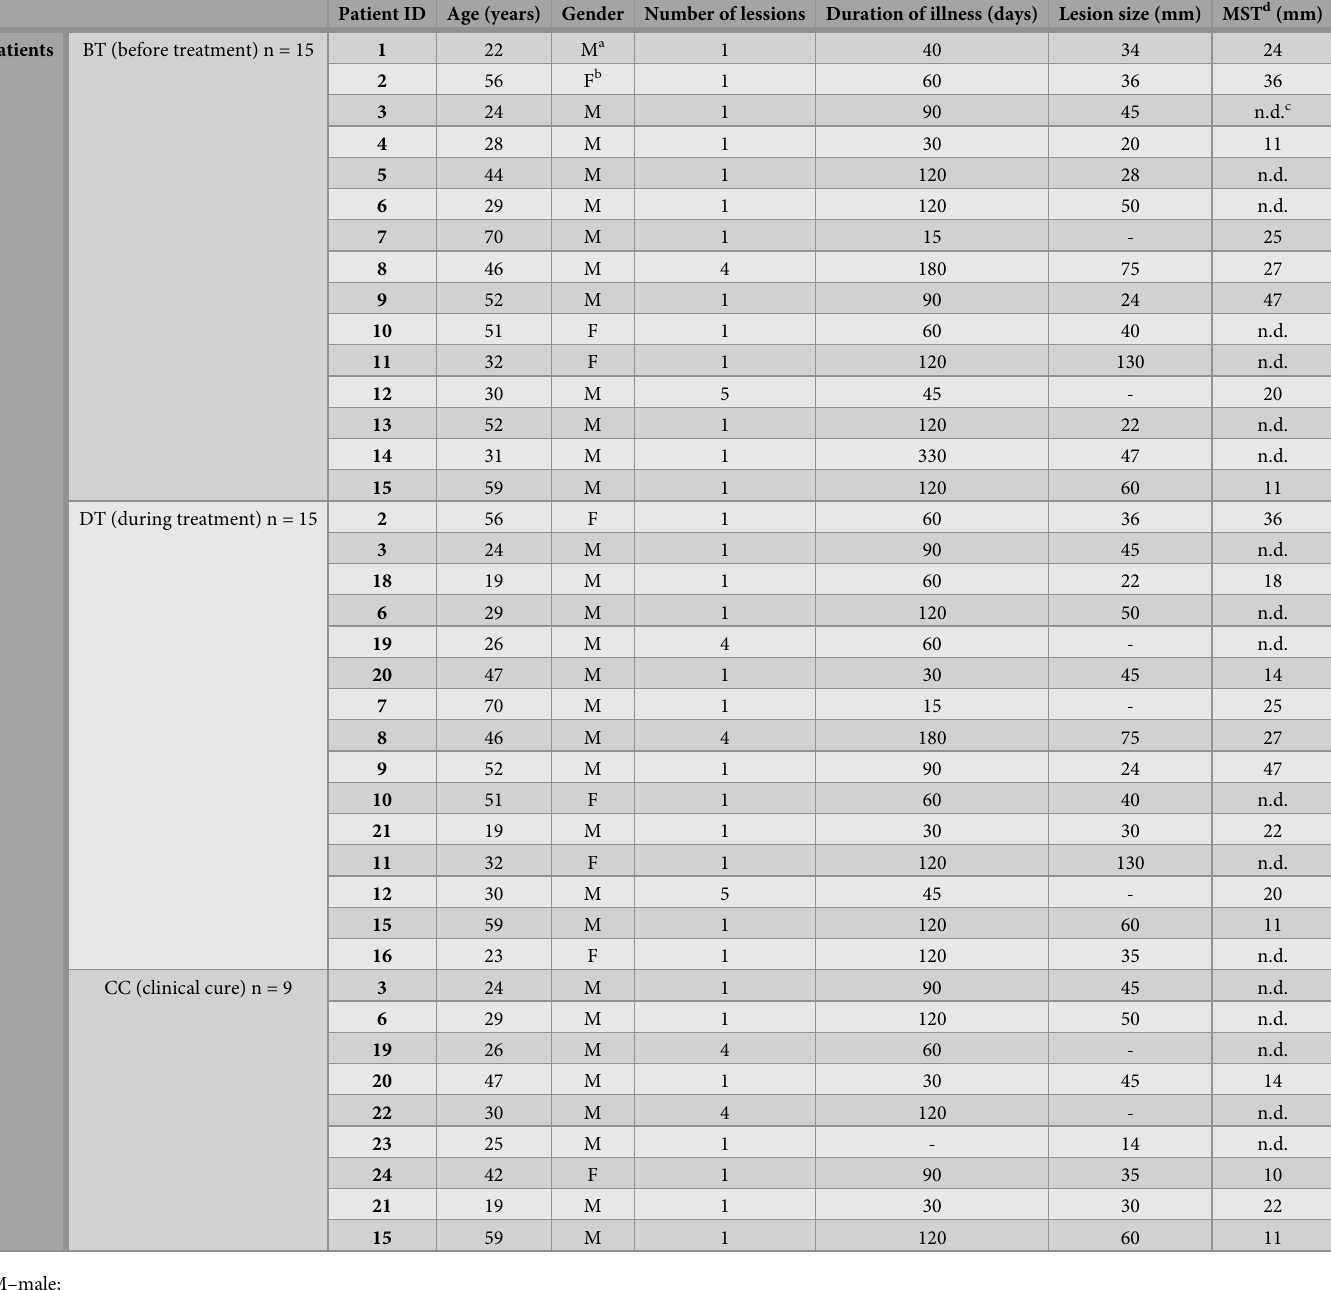
Table 1. Characteristics of cutaneous leishmaniasis patients enrolled in this